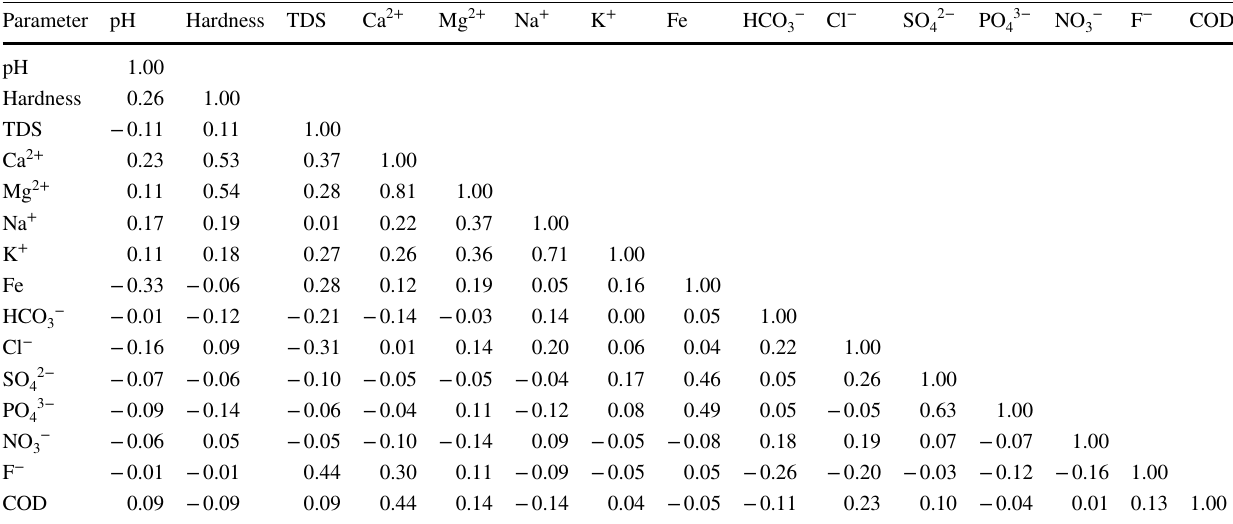
Table 13 Correlation matrix of the physicochemical parameters of the surface water samples in the dry season (taking average values) Parameter